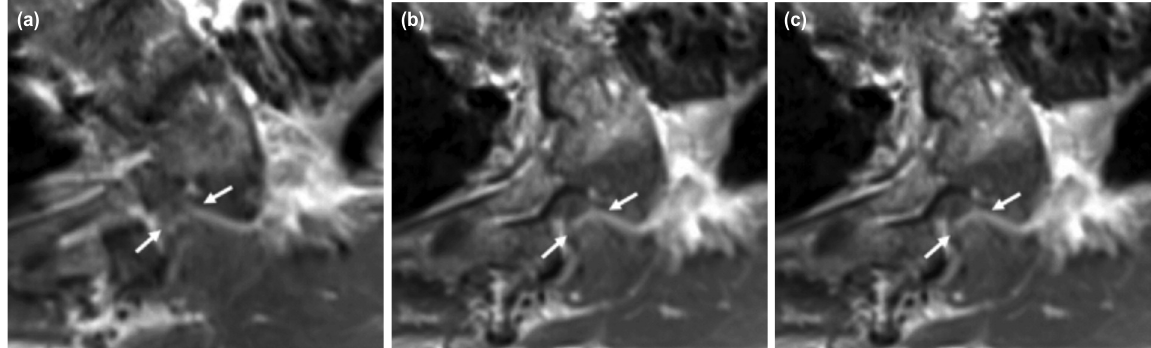
(a, b, c) MRI of the spine of Case 4 showing cord compression at T4/5 level due to a neurofibroma (white arrow). Fig. 5: